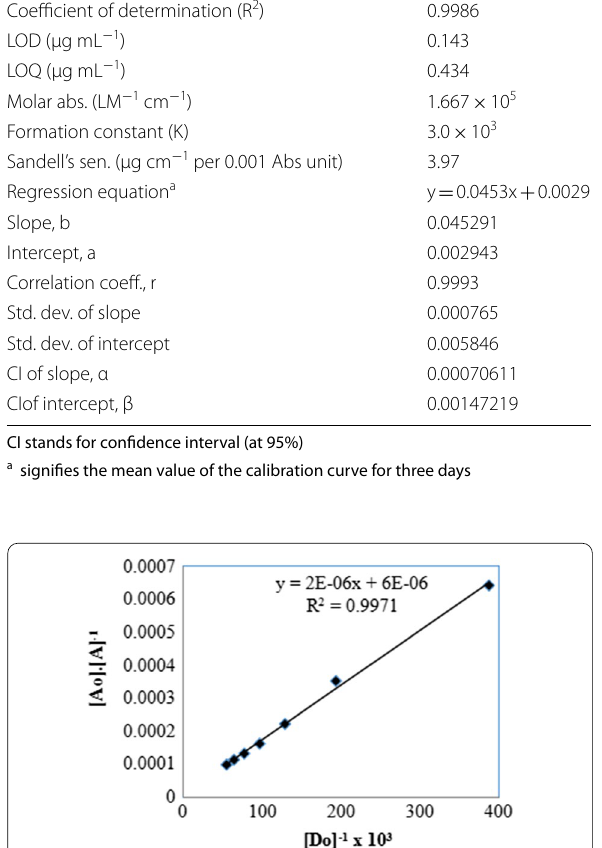
Figure 3 represents the continuous variation method curve according to Job’s method.